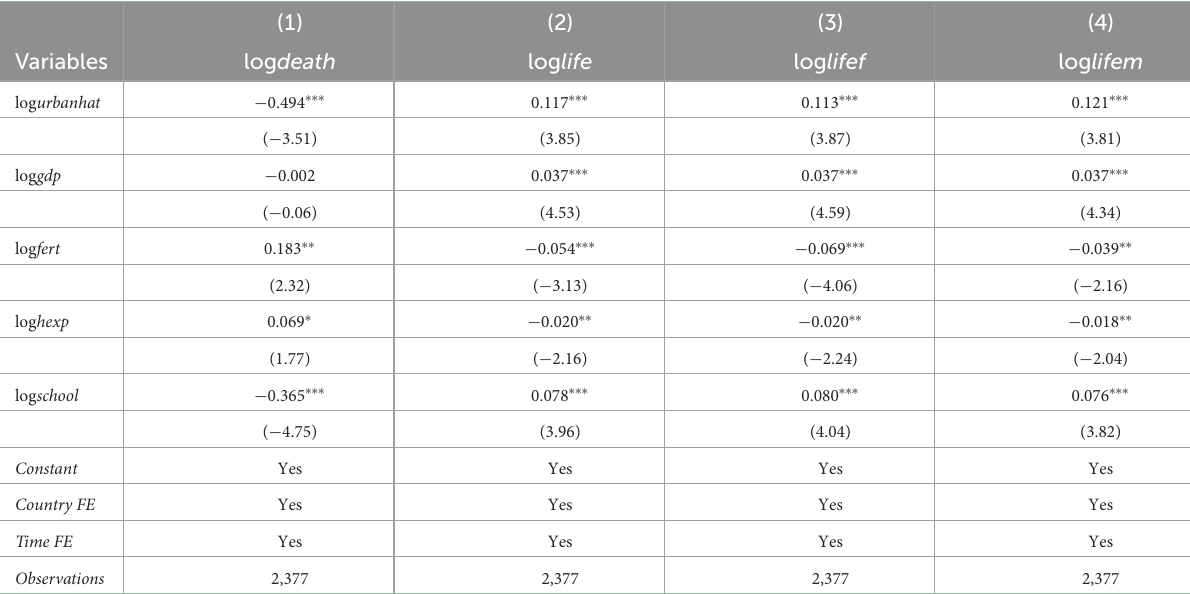
TABLE 7 2SLS estimation